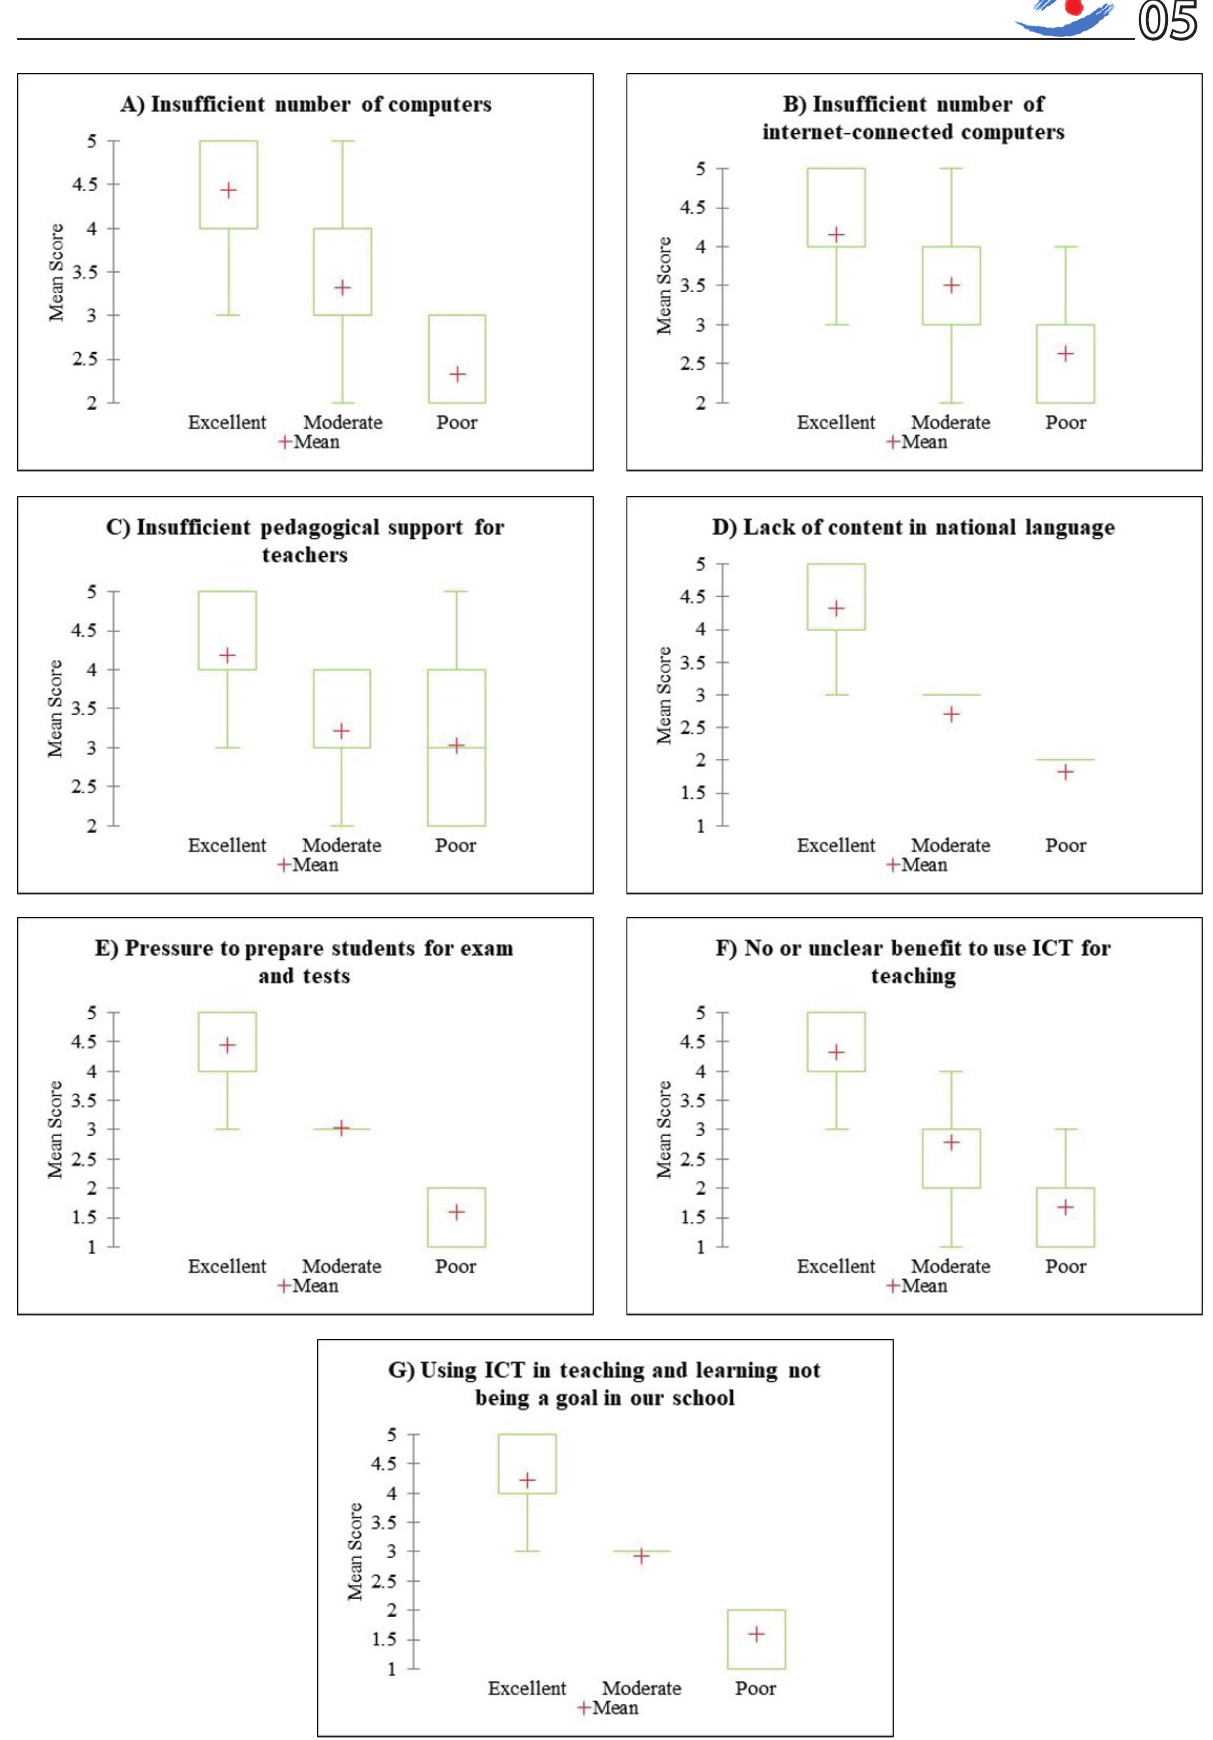
Figure 2. Significant perceived barriers parameters for excellent, moderate, and poor groups applying technology in